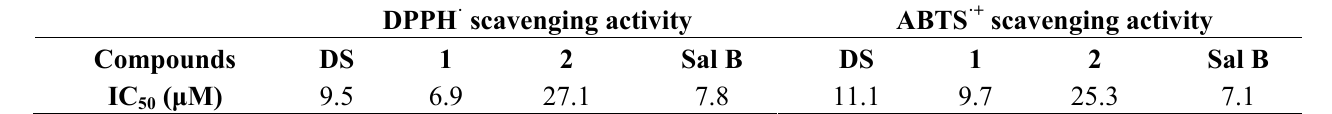
Table 2. DPPH · and ABTS ·+ scavenging activity ( in vitro